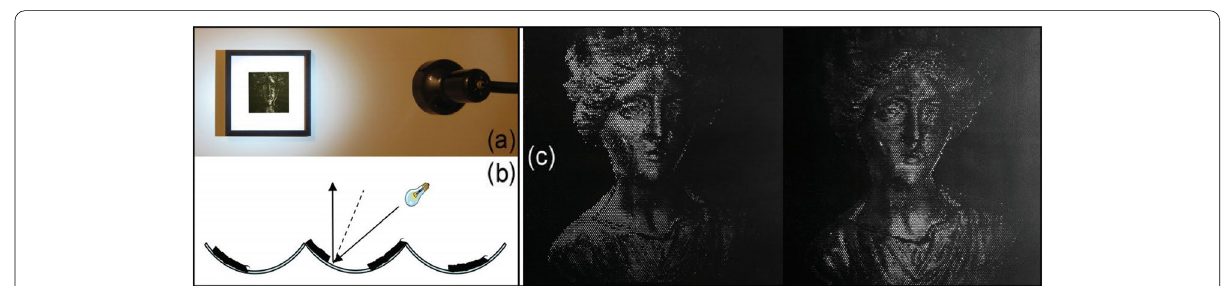
Fig. 19 Malzbender et al.[38] presented an algorithm for producing paintings whose reflectance is similar to a real 3D